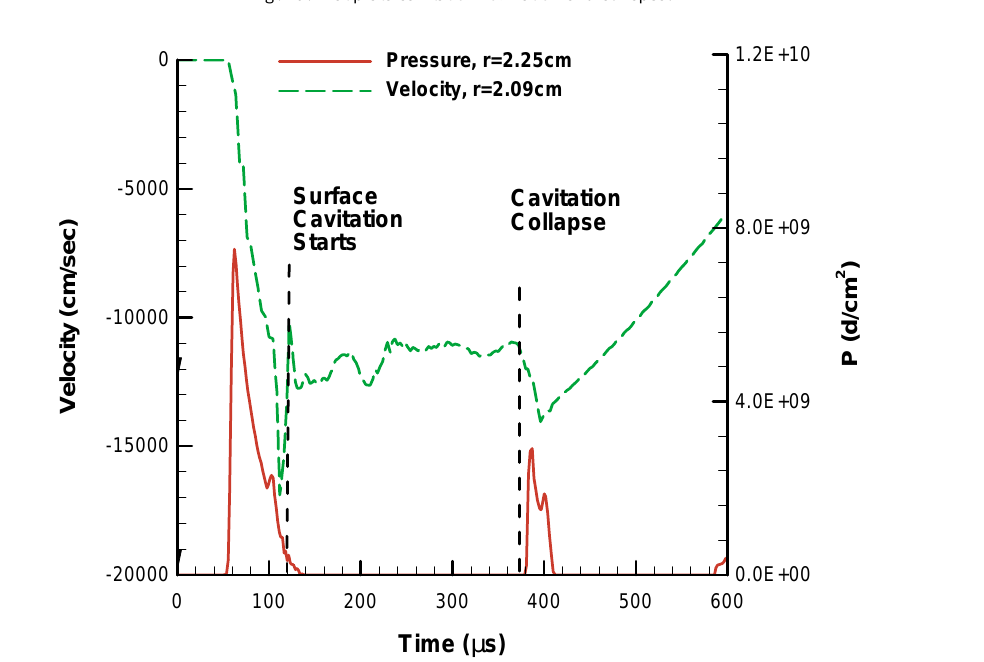
Fig. 11. Flat plate centerline velocity and pressure